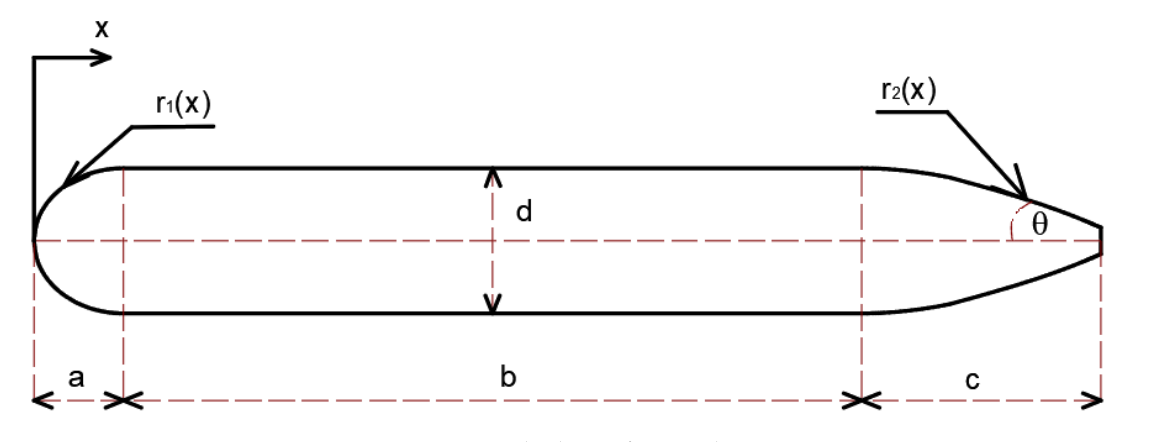
Figure 1. Body shape of a torpedo. Table 1. Torpedo geometric parameters used for computation.